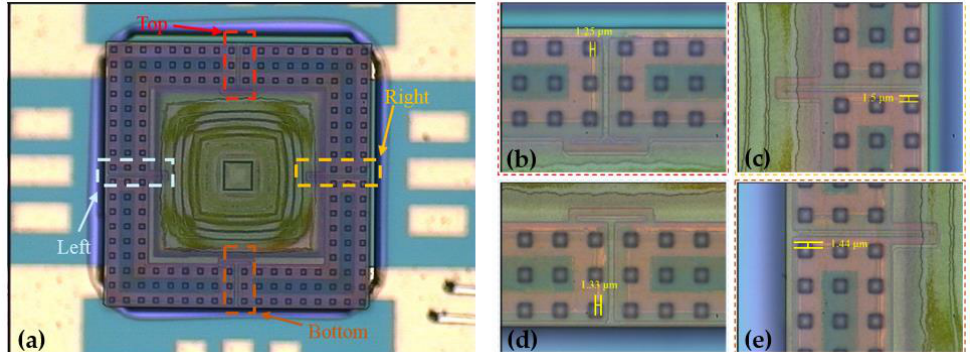
Figure 11. Microscopic view of transferred device and flip-chip bonding precision after the Au–Si eutectic flip-chip bonding process. ( a ) Microscopic view of transferred device; ( b – e ) Deviations of the top, right, bottom, and left metal electrode between the tactile sensor and the reroute substrate of approximately 1.25, 1.5, 1.33, and 1.44 μm, respectively.